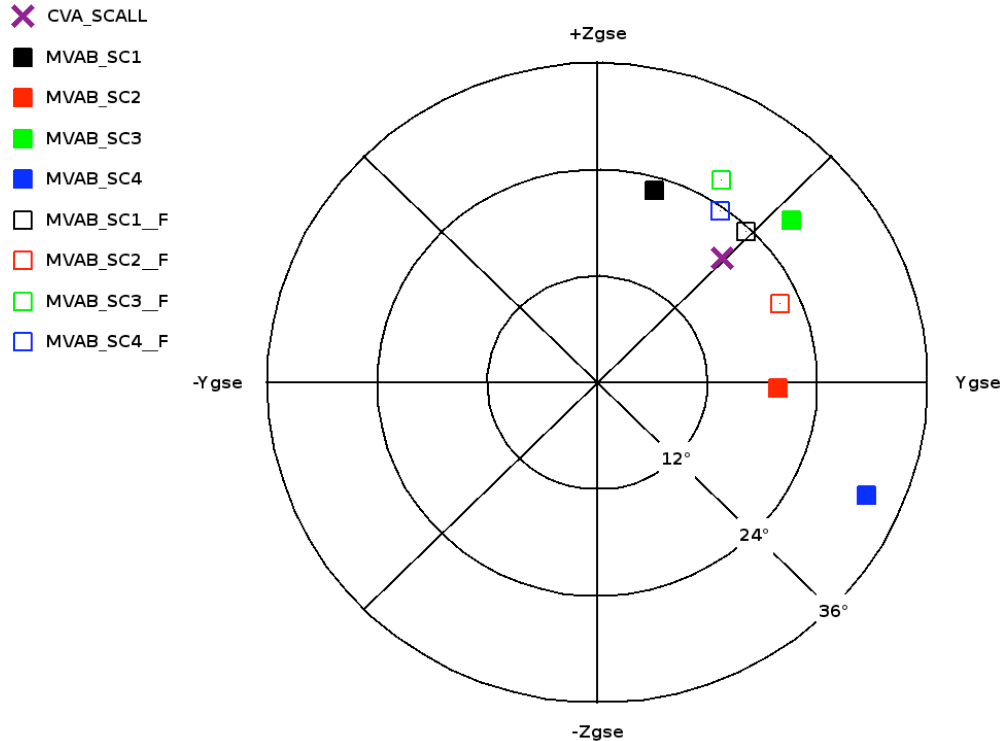
Fig. 6. Polar plot of MVAB normal vectors for the rapid rotation interval (filled squares) and for the full ( F =rapid + slow) time interval (unfilled squares) of the Cluster event (colors: C1 black; C2 red; C3 green; C4 blue). Time intervals are listed in Table 1. At the center is the direction of the GSE X-axis. Four-spacecraft timing, along with the constant velocity assumption, CVA (purple cross), gives n CVA = ( 0 . 9436 ; 0 . 2306 ; 0 . 2374 ) , using the following spacecraft locations (GSE components in R E ) and time lags (Fig. 7) relative to C4: C1 =[ 16 .